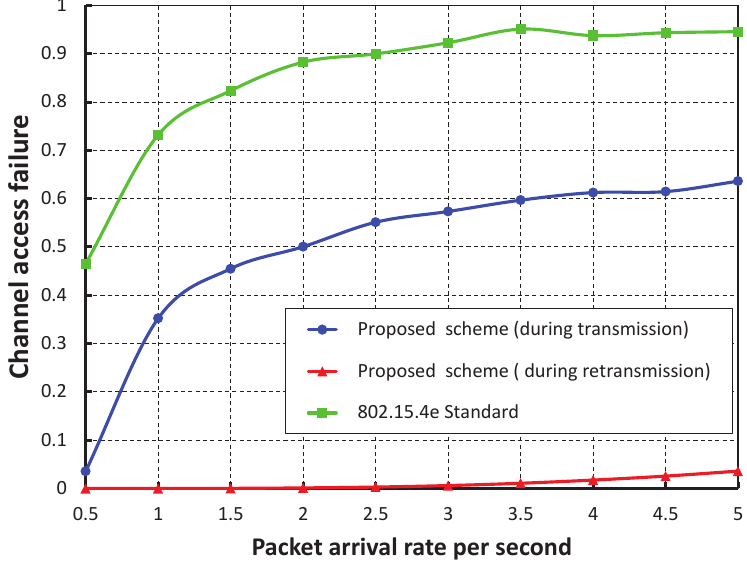
Figure 10. Comparison of channel access failure for different numbers of